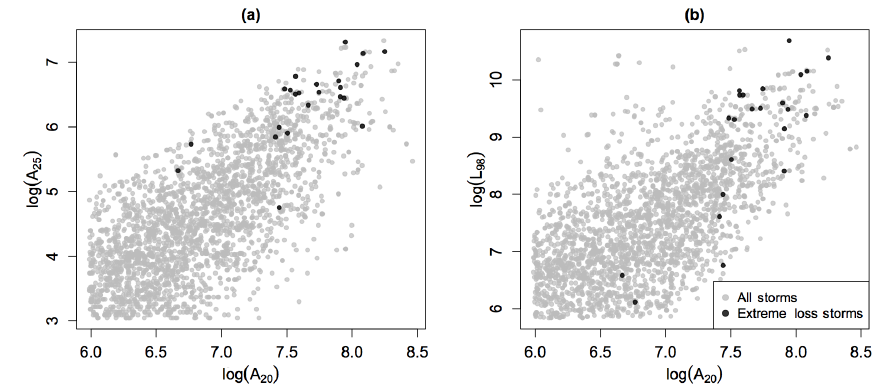
Figure 2. The relationship between (a) the logarithm of the damage area SSIs A 25 and A 20 (correlation 0.778), and (b) the logarithm of the Klawa and Ulbrich (2003) loss function ( L 98 ) and the logarithm of A 20 (correlation 0.715) for the top 50% of the 6103 windstorms in each variable. The 23 notable, large insurance loss storms, defined in Roberts et al. (2014), are shown in black.